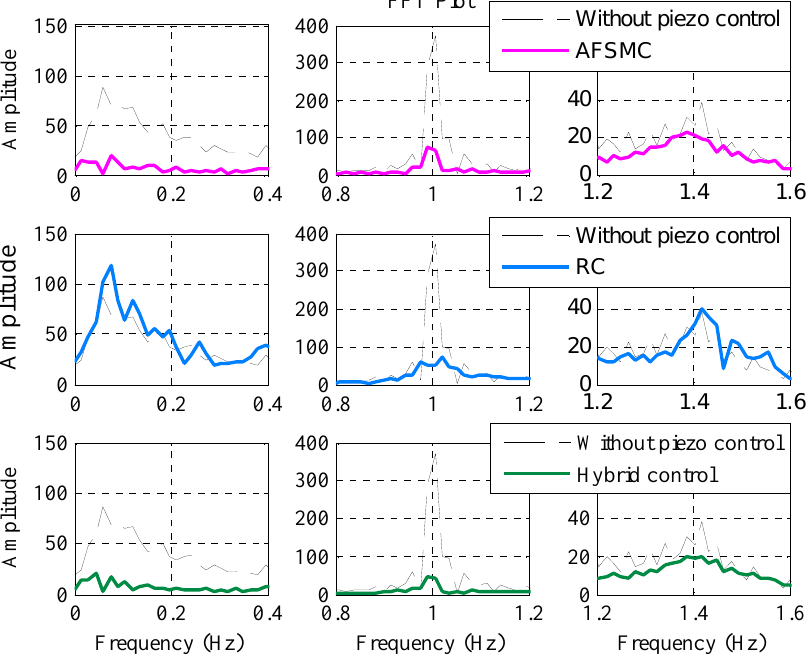
Figure 13. Piezoelectric vibration control for the flexible structure system: FFT analysis ( left ) low frequency range; ( middle ) 1 Hz; and ( right ) resonance frequency of 1.4 Hz.